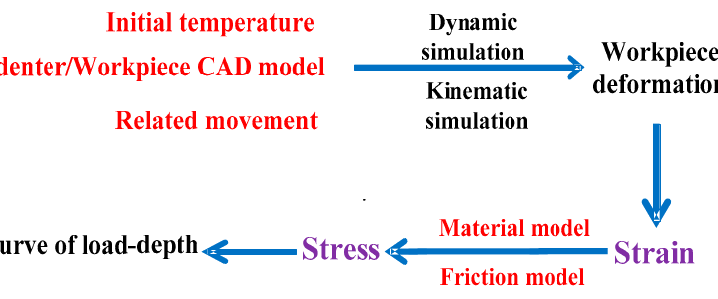
Figure 5. The procedure of numerical calculation.